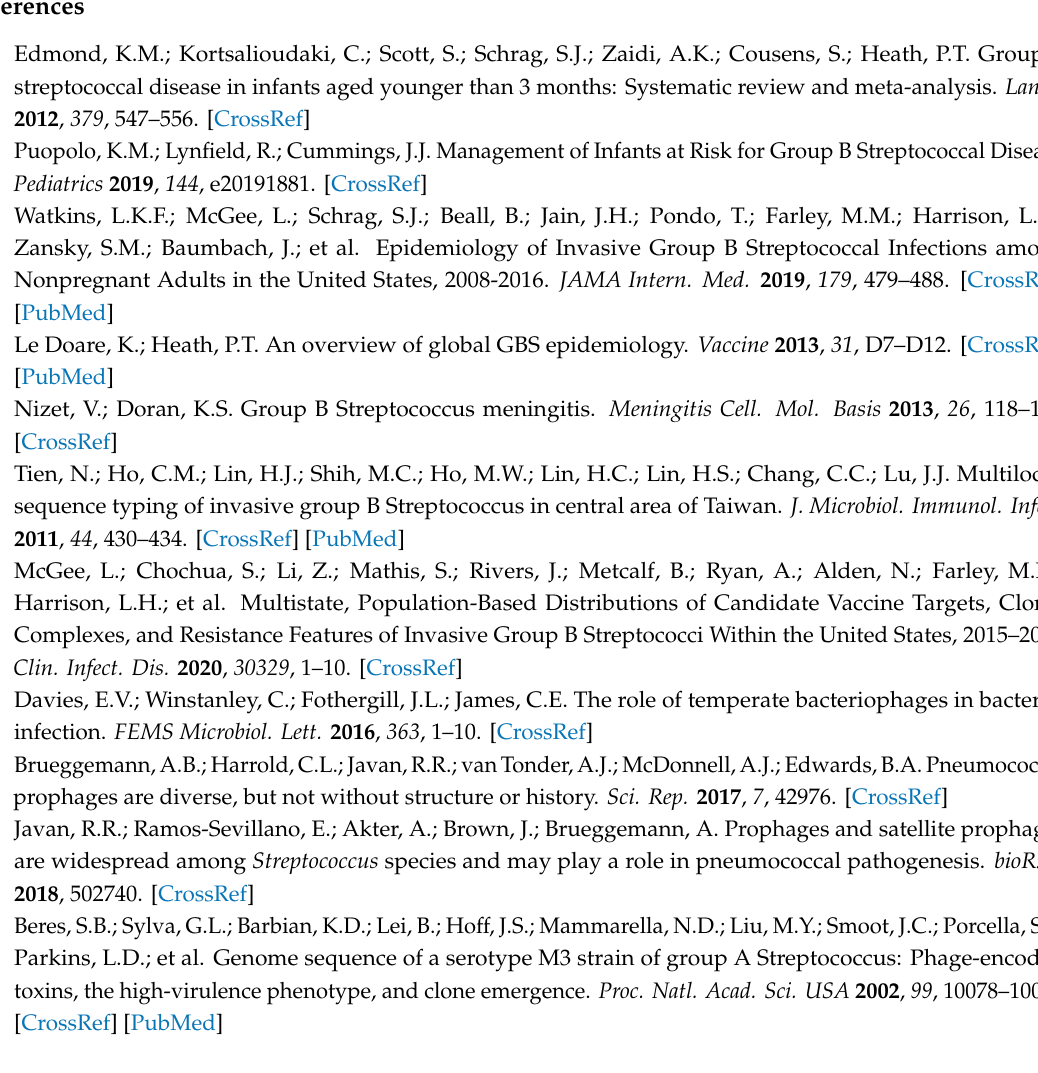
Figure S1: Distribution of clinical and pregnancy screening strains and serotypes according to sequence types in 123 GBS strains. Table S1: List of primers. Table S2: GBS strains used in the study. Table S3: Sequenced GBS genomes. Table S4: Characterization of prophages from sequenced GBS genomes. Table S5: CRISPR-Cas systems in present sequenced GBS genomes. Table S6: Prophage